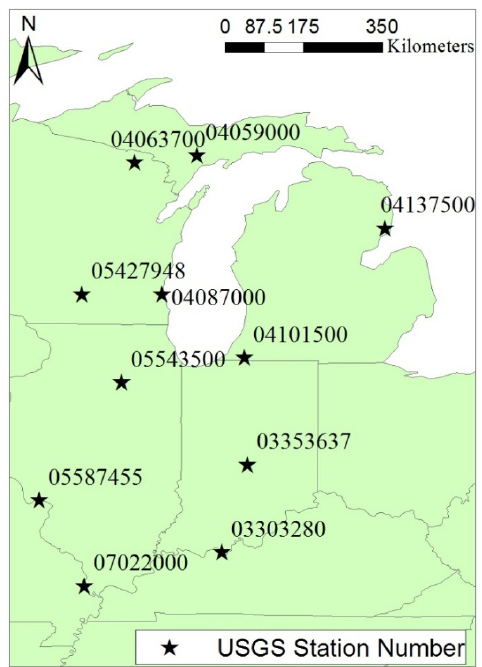
Figure 3 . Location of USGS stations for streamflow and nitrogen